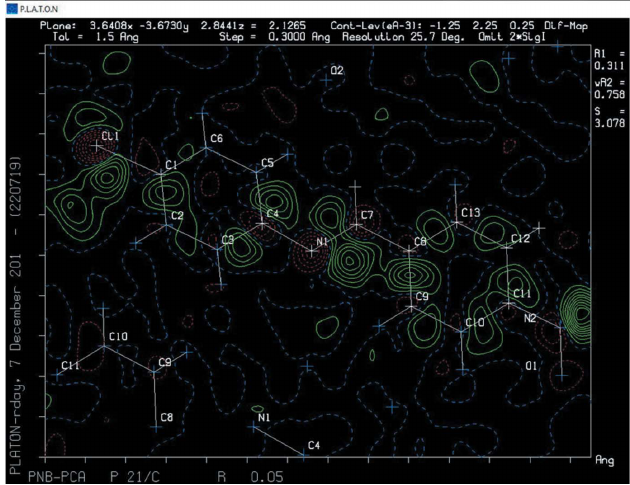
Figure 3 A difference electron-density map showing the density peaks related to the minor disordered component.